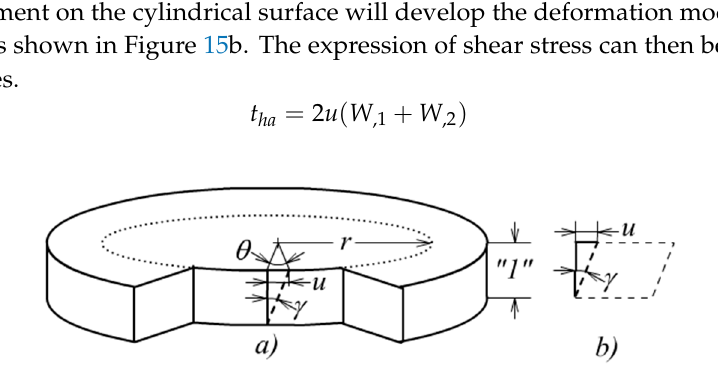
Figure 15. ( a ) Shear deformation of the cylinder and ( b ) Shear deformation of micro element.